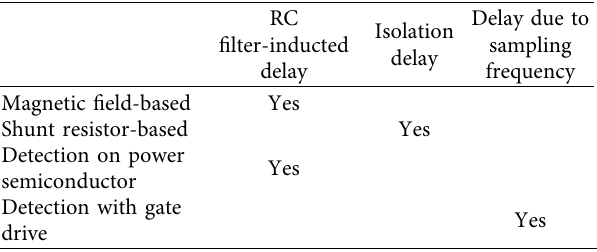
Table 4: Dominant sensing response time contributors for the over-current detection